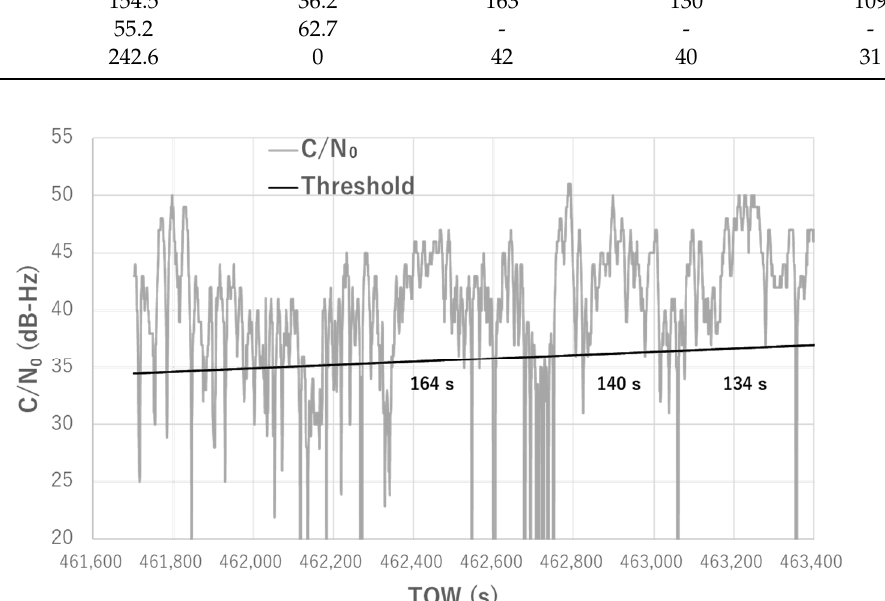
/ N Figure 9. Real C/N 0 for GPS 22 with elevation-dependent threshold and three longest periods. Figure 9. Real C 0 for GPS 22 with elevation-dependent threshold and three longest